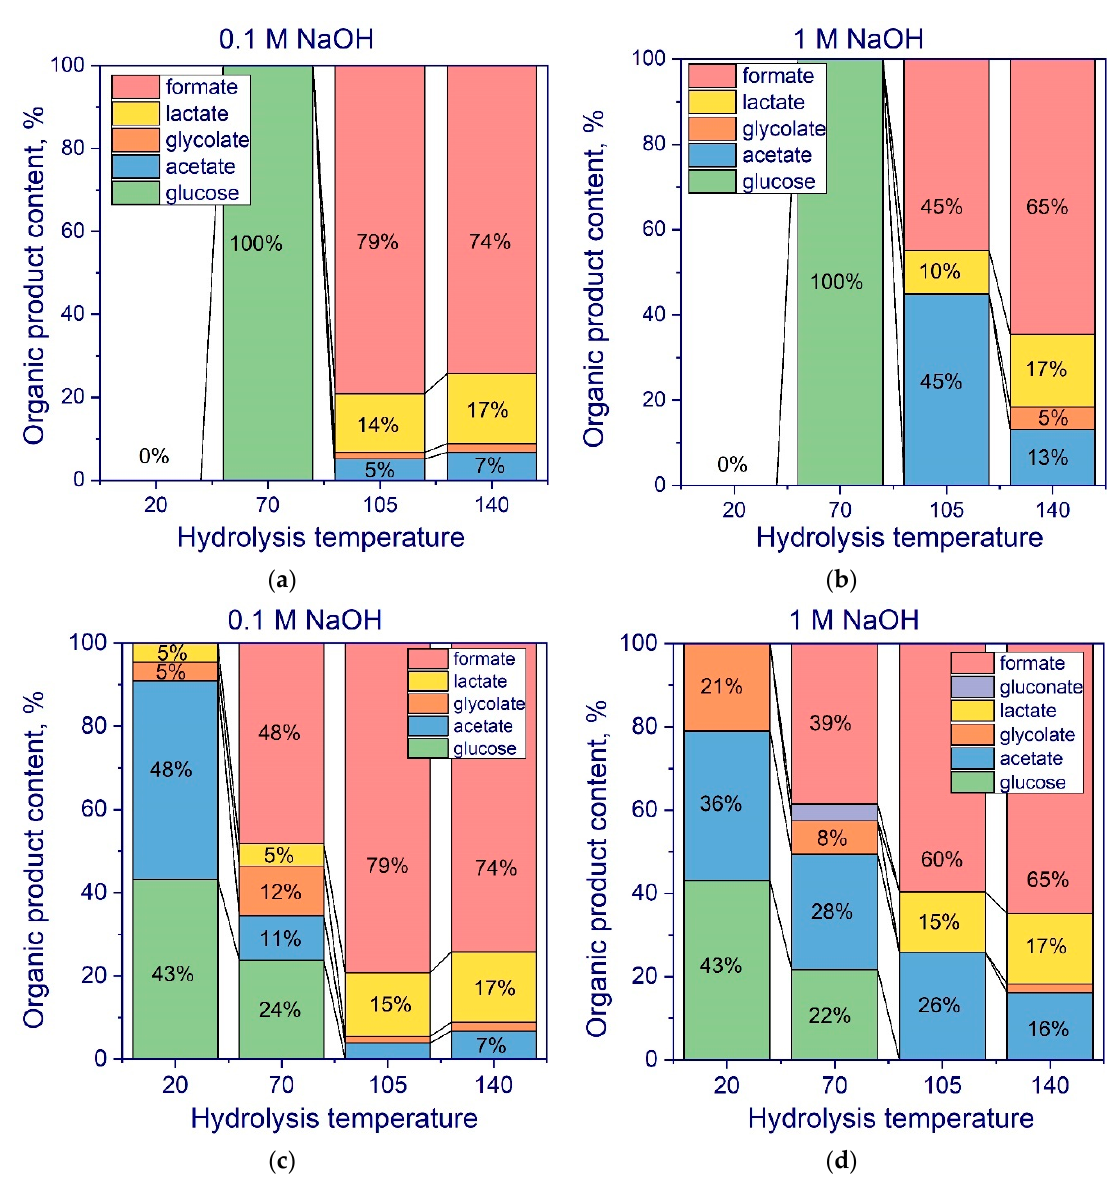
Figure 6. The dependence of organic compound distribution on the pretreatment temperature before ( a , b ) and after ( c , d ) H 2 evolution reaction. T = 20 °C in the case of no pretreatment; C 0 (NaOH) = 0.1 M ( a , c ) and 1 M ( b , d ).